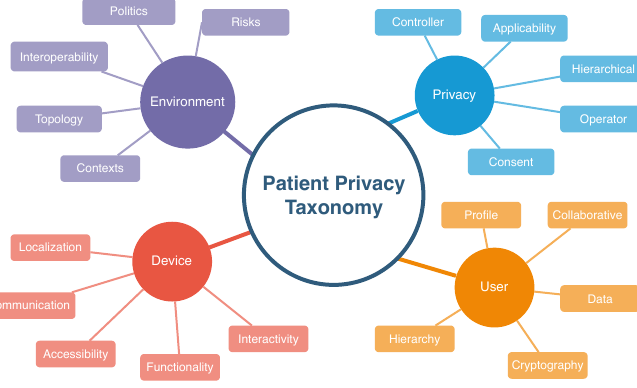
Figure 1. Proposed